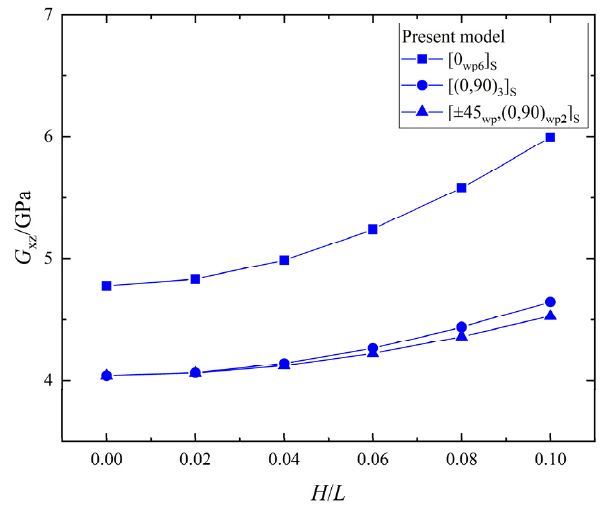
Figure 15. The shear stiffness, G xz , vs. wrinkle parameter, H/L , in laminates.